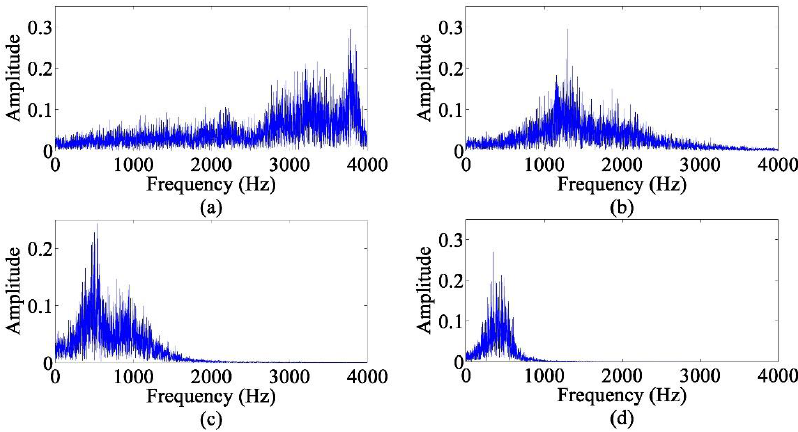
Figure 5. The amplitude spectra of each intrinsic mode function (IMF) after empirical mode decomposition (EMD). ( a ) IMF1. ( b ) IMF2. ( c ) IMF3. ( d ) IMF4. decomposition (EMD). ( a ) IMF1. ( b ) IMF2. ( c ) IMF3. ( d )